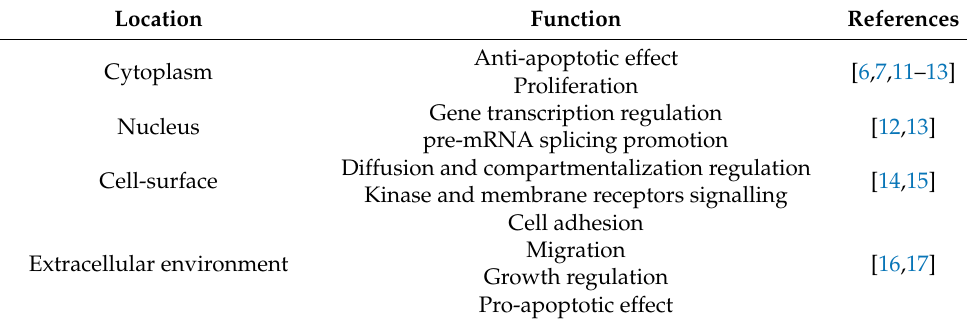
Table 1. Various functions of galectin-3 in relation to cellular location.